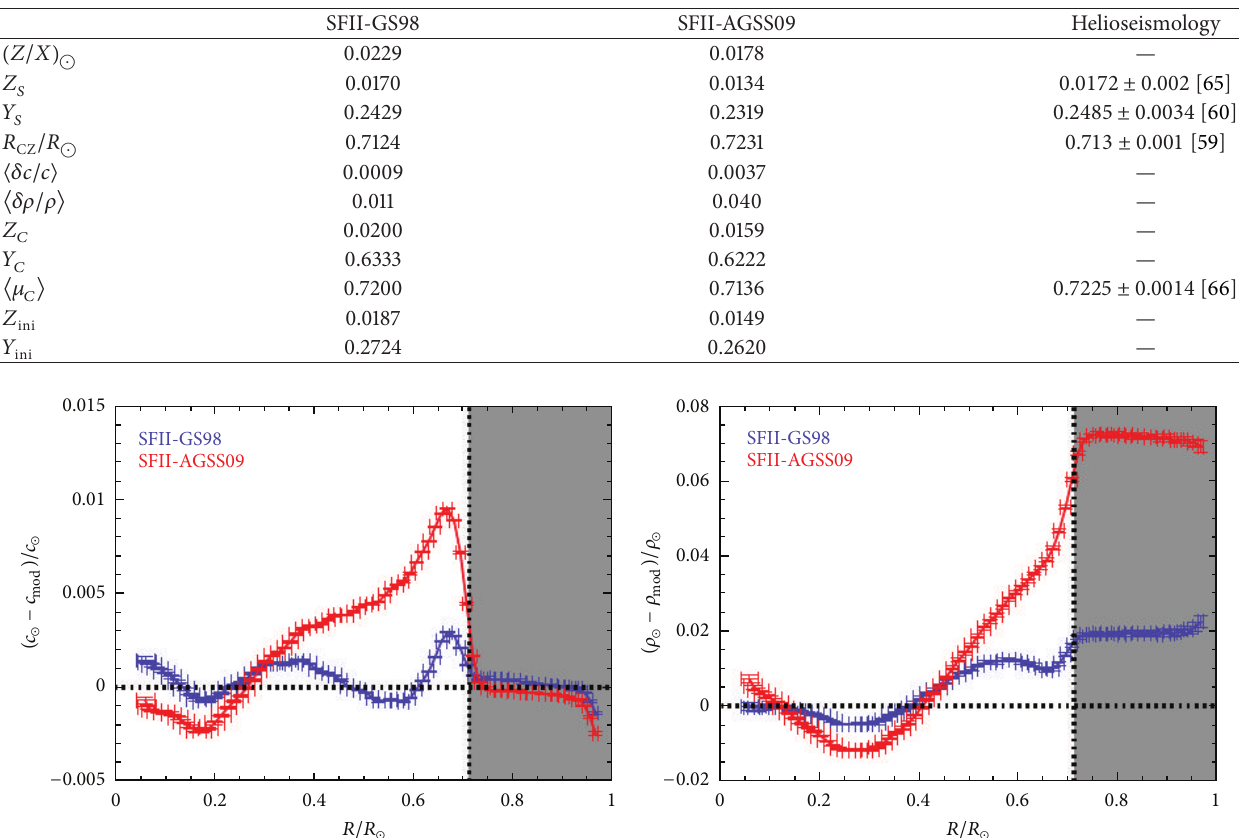
Table 3: Main characteristics of SSMs representative of high-Z (GS98) and low-Z (AGSS09) solar compositions. Models have been computed including the most up-to-date input physics [64]. Helioseismic constraints are given when available. See text for details.